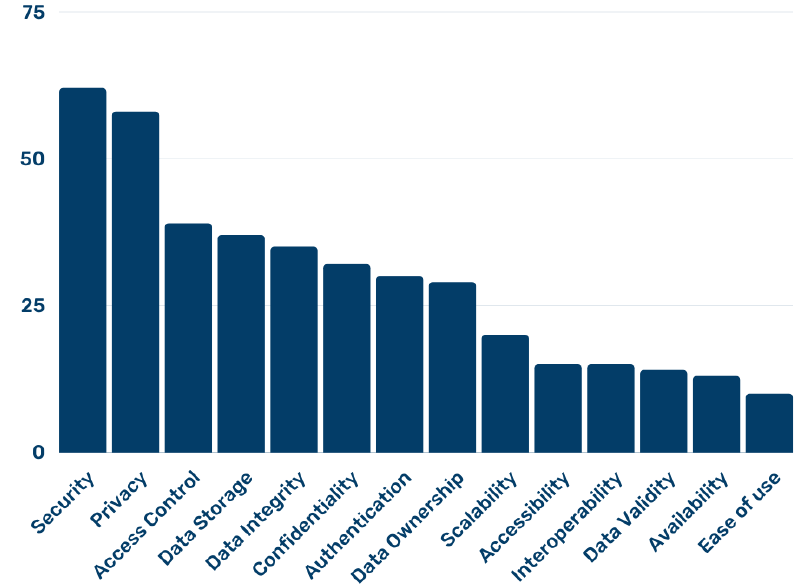
Figure 6. Number of papers addressing each EHR challenge.